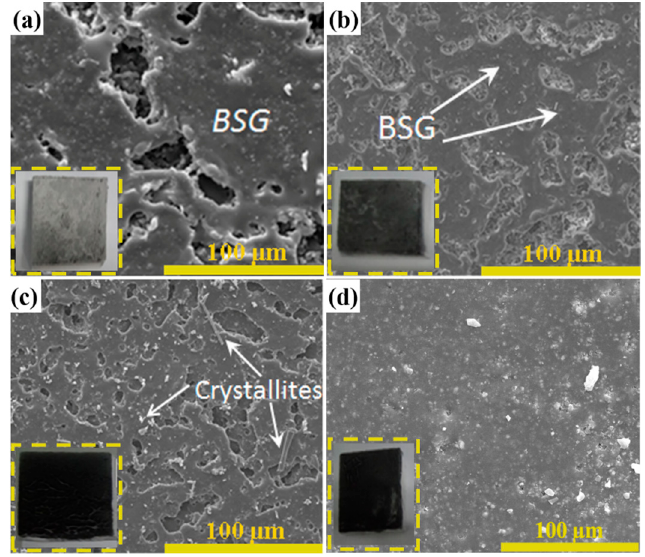
Figure 2. Surface micromorphology of as-prepared RCG coatings samples with different sintering temperatures: ( a ) 1050 °C; ( b ) 1100 °C; ( c ) 1150 °C; ( d ) 1200 °C; the insets show macroscopic photos of the samples. Sintering parameters: Heating rate: 10°C/min, inserting temperature: 30 °C, holding time: 1 h, and cooling down with the furnace.